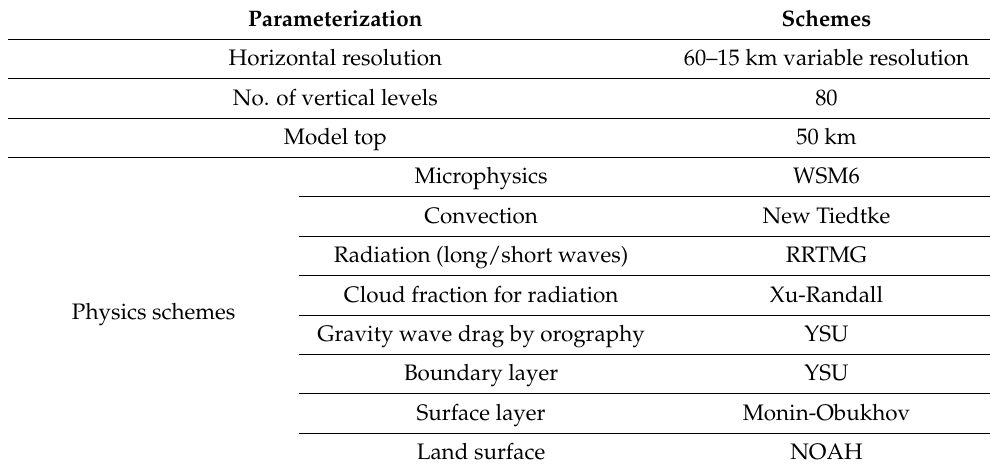
Table 1. MPAS (version 7.0) model